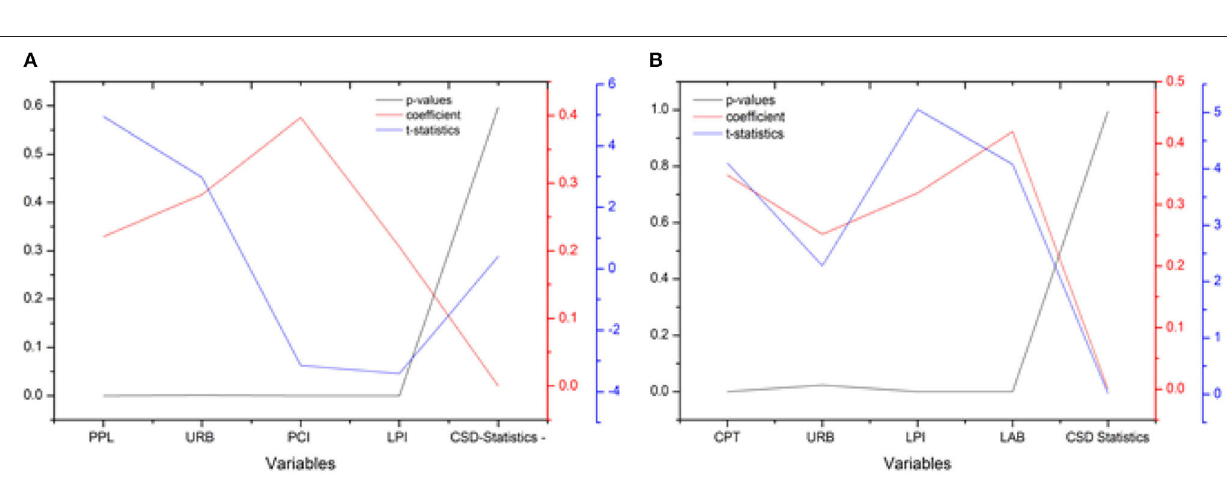
FIGURE 5 | Results of CS-ARDL Long run test (A) DV: EG, (B) DV: CE.